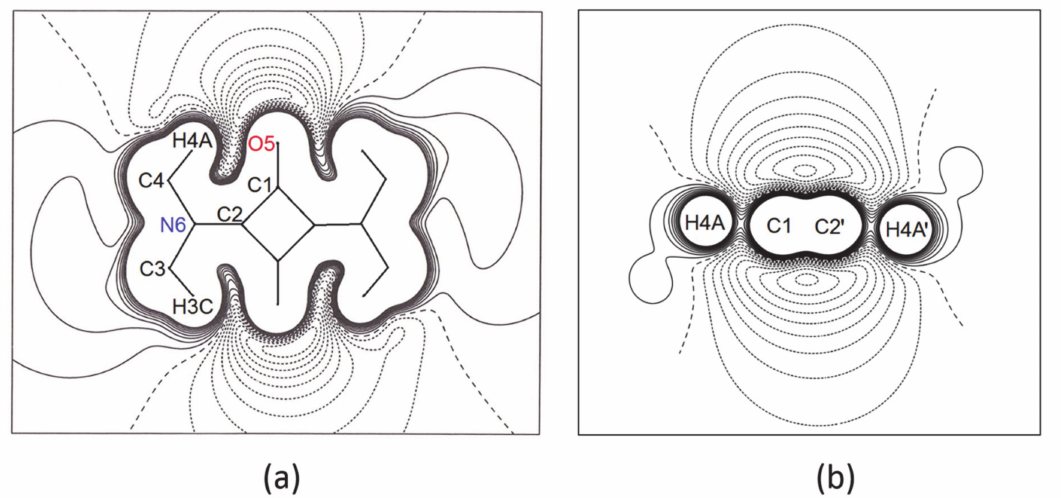
Figure 7. ( a ) Experimental electrostatic potential Φ ( r ) of SQ in the mean molecular plane, extracted from the crystal, as computed from a model with isotropic H atoms. Contour levels run from − 0.09 to + 0.09 e · Å –1 at steps of 0.01 e · Å –1 (1 e Å –1 = 1389 kJ · mol –1 = 14.4 V). All the atoms within 0.1 Å from the plane are shown. ( b ) Same as ( a ), plotted in the perpendicular plane passing through the C1–C2 and C1 (cid:48) –C2 (cid:48) midpoints Negative and zero contours: short and long dashed lines, respectively; positive contours: solid